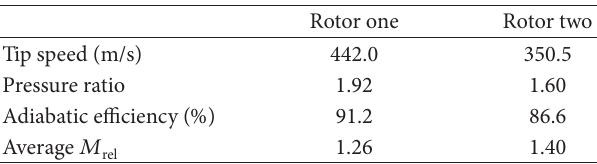
T 1: Aerodynamic parameters of rotor one and rotor